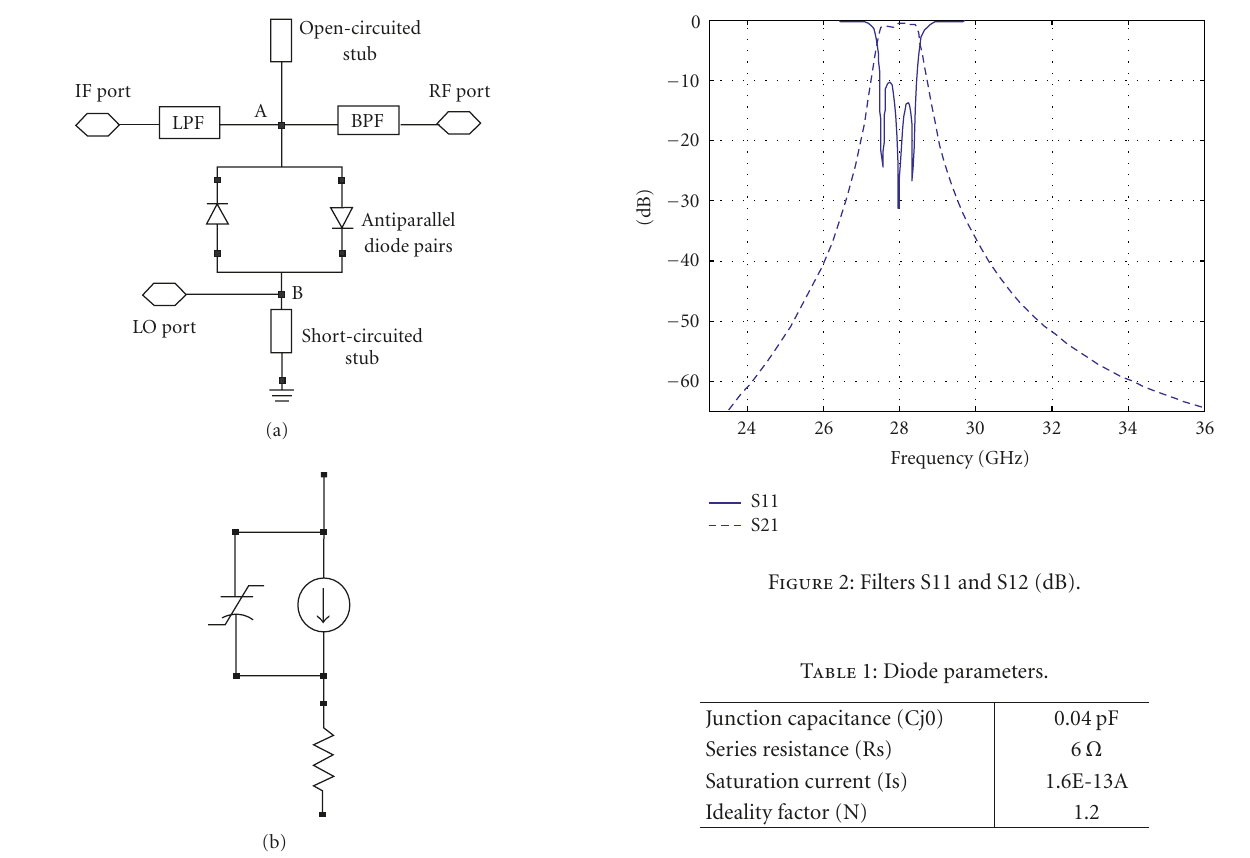
Figure 1: (a) Circuit configuration of the even harmonic mixer, (b) Schottky diode nonlinear model.